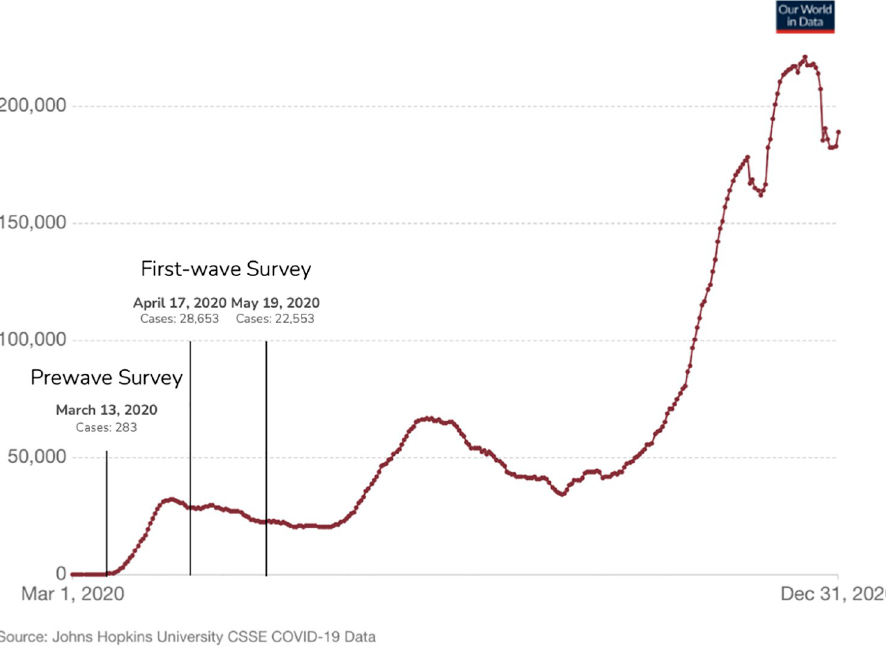
ourworldindata.org. Case data provided by the COVID-19 data repository at the Center for Systems Science and Engineering (CSSE) at Johns Hopkins University.